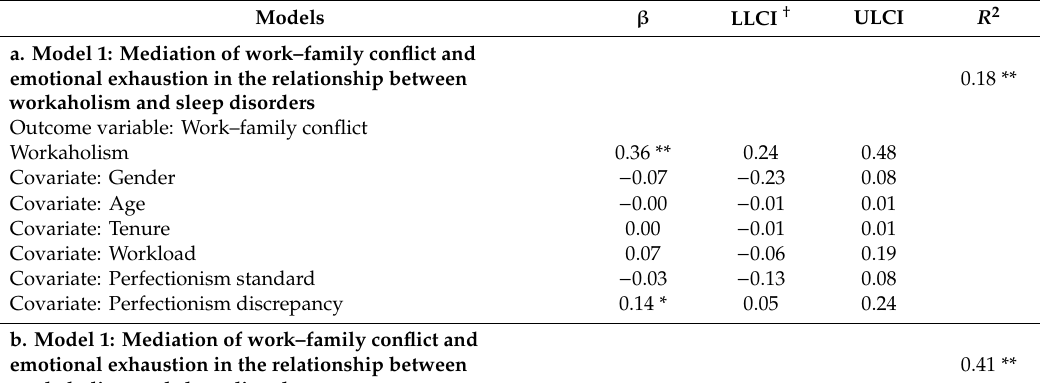
Table 2. Results of conditional process